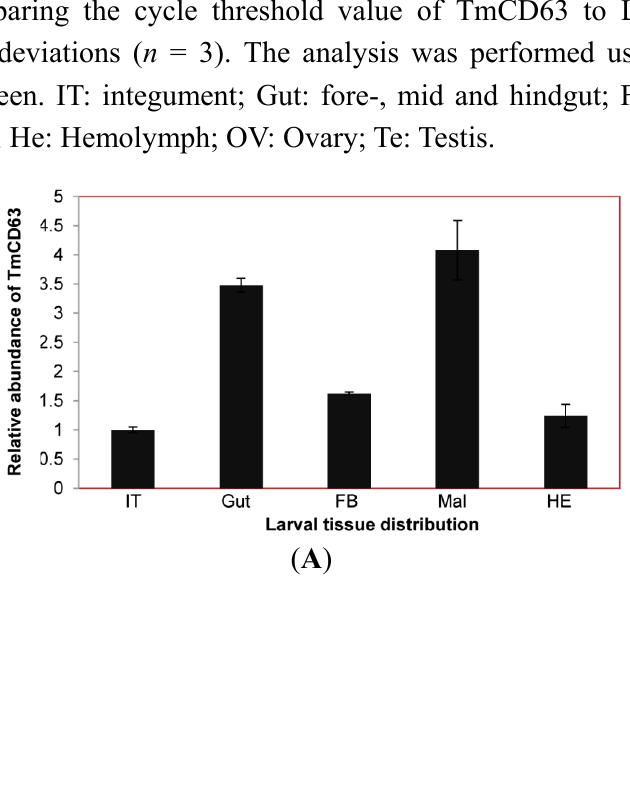
Figure 8. Tissue-specific expression study of TmCD63 in mealworm beetle T. molitor . ( A ) The distribution of the transcript in last instar larval tissues; and ( B ) The distribution of the transcript in 2-day-old adult tissues. Ribosomal protein L27a ( T. molitor ) was used as an internal control to normalize RNA levels between samples. The relative expression was calculated by comparing the cycle threshold value of TmCD63 to L27a. Vertical bars represent standard deviations ( n = 3). The analysis was performed using real-time PCR based on SYBR green. IT: integument; Gut: fore-, mid and hindgut; FB: Fat body; Mal: Malphigian tubules; He: Hemolymph; OV: Ovary; Te: Testis.